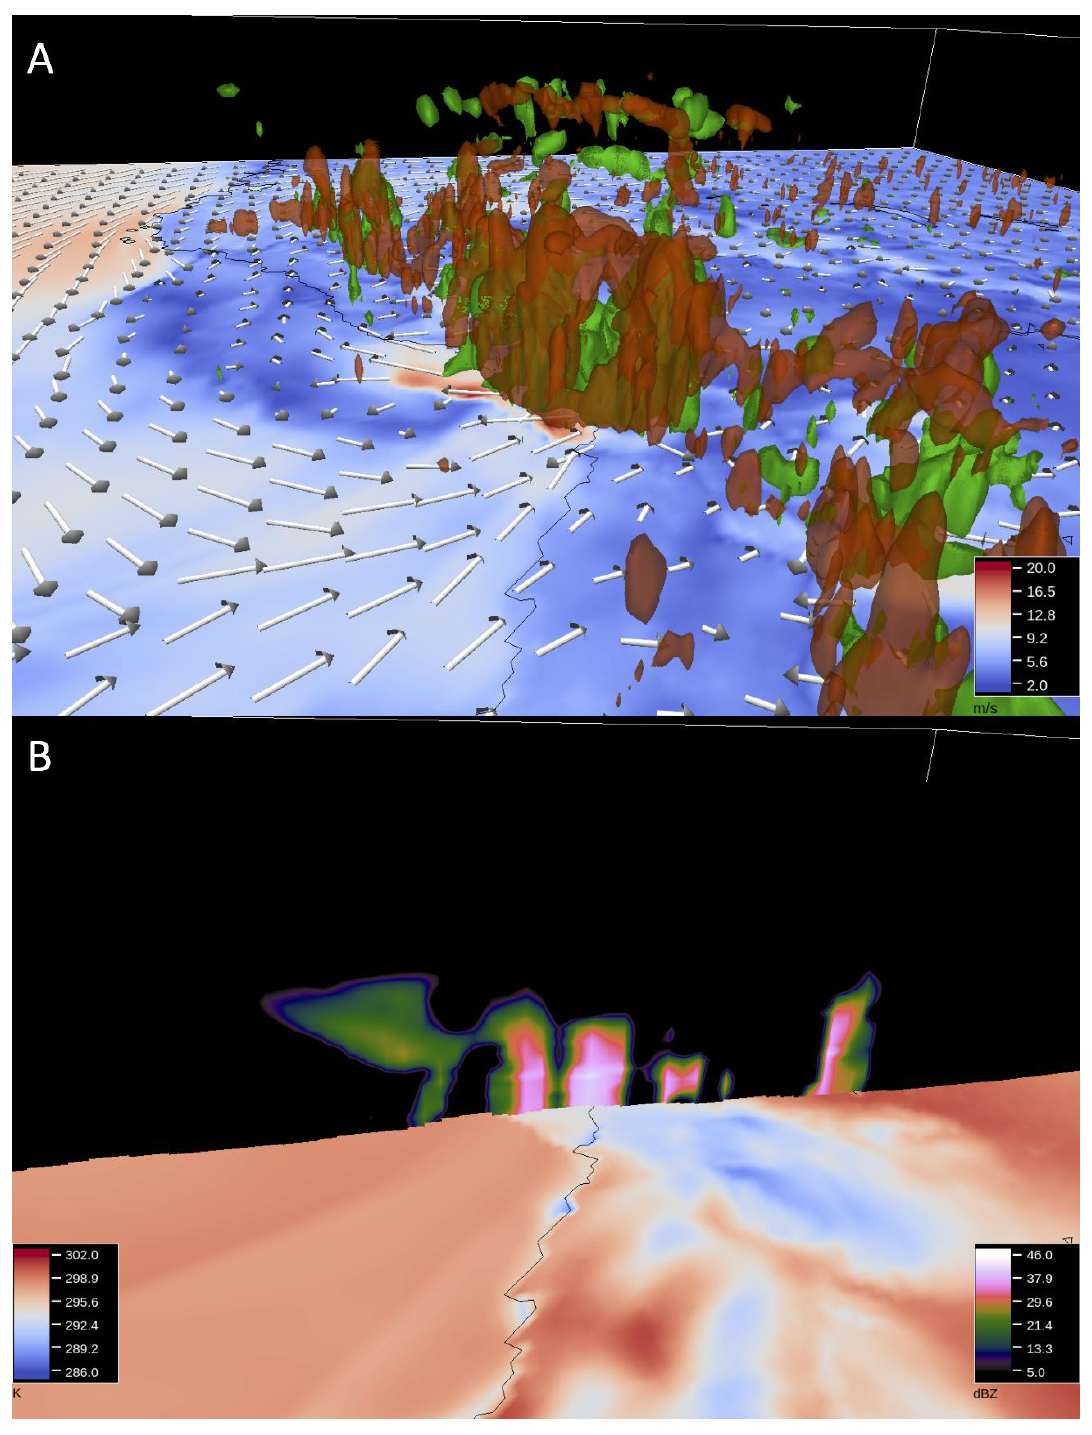
Figure 21. The WRF-IFS-DA results at 11:30 UTC above the Genoa region. ( A ) The updraft and downdraft system (red and green isosurfaces are ±1 m s −1 ) in combination with the 10 m maximum wind speed (m s −1 , vectors and colors). ( B ) A vertical cross section of the reflectivity field (dBZ) and the 2 m temperature (K).